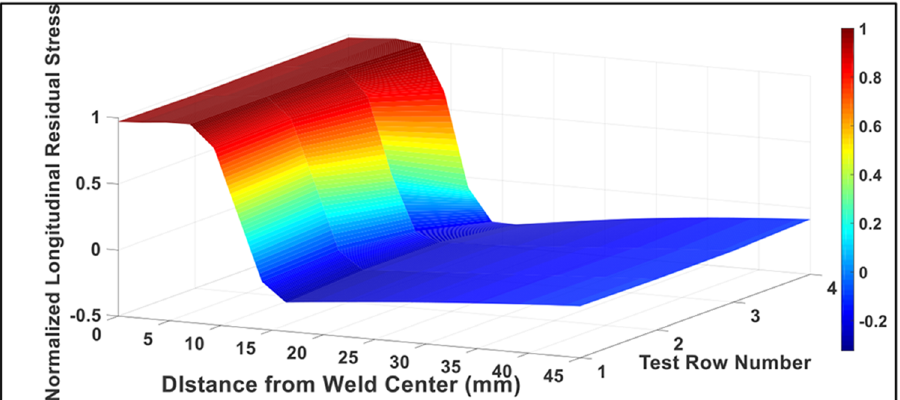
Fig. 7. Distribution of longitudinal residual stress on welded sample from